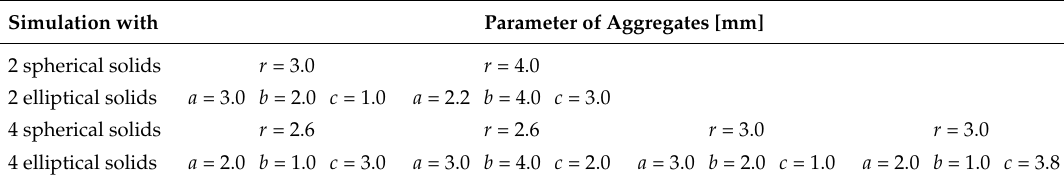
Table 2. Summary of parameters of solid aggregates for the four different simulation scenarios. Spherical solids are defined by their radius r while ellipsoidal solids are defined by their half-axes a , b and c (dimension in e x -, e y - and e z -direction, respectively). Simulation